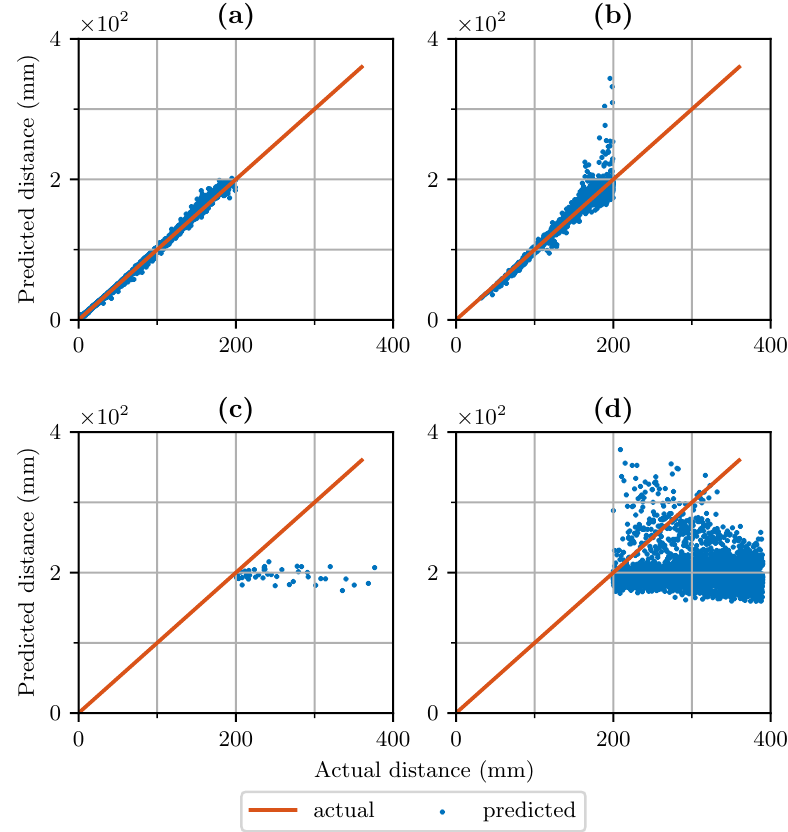
Figure 5. Results of distance prediction with data quality indication of data set 2 based on SVM-829. ( a ) True positive predictions with good data quality, ( b ) false negative predictions. ( c ) false positive predictions, ( d ) true negative predictions with low data